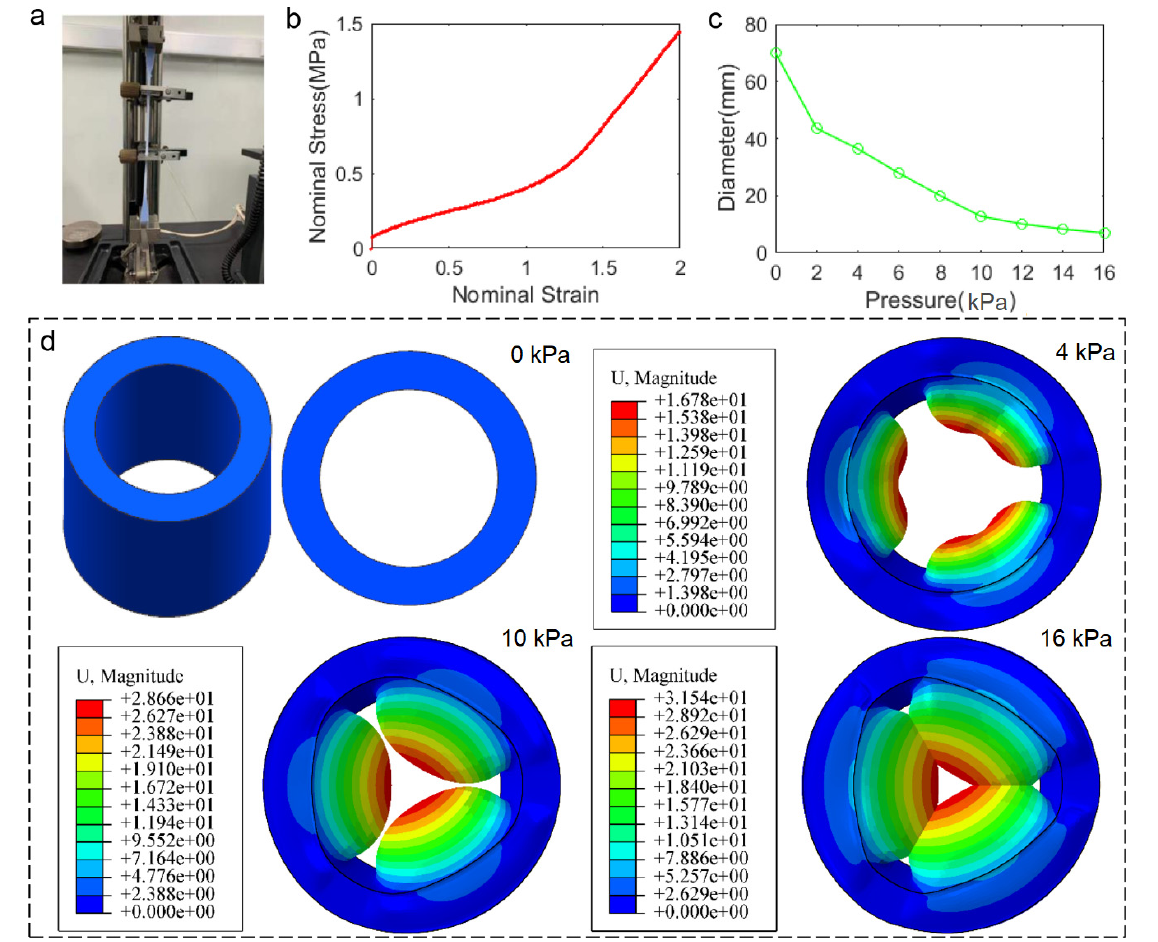
Figure 5. ( a ) Uniaxial tensile tests. ( b ) The averaged nominal stress-strain curve of dumbbell specimens. ( c ) The relationship between inscribed circle diameters and input air pressures of finite element simulation. ( d ) The inflated state of finite element model at 0 kPa, 4 kPa, 10 kPa, and 16 kPa respectively.